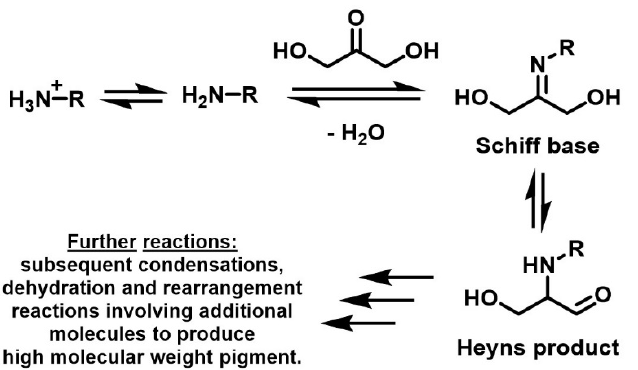
Figure 3. Reactions of DHA with amino groups leading to pigment formation (melanoidins). Adapted from [21] with permission from Elsevier.